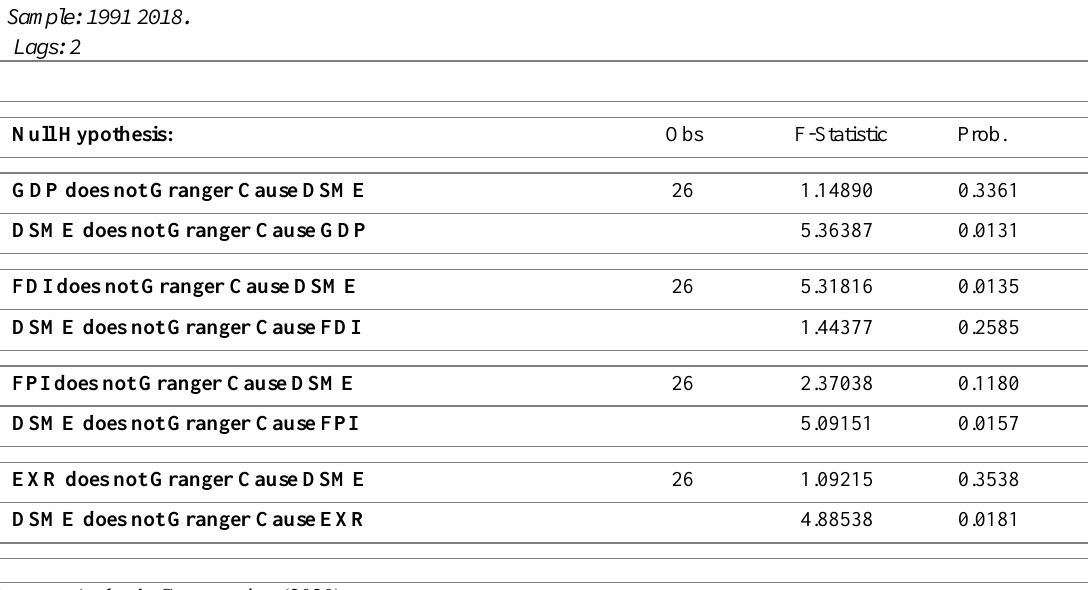
Table 6: Results of the Granger Causality Tests: Pairwise Granger Causality